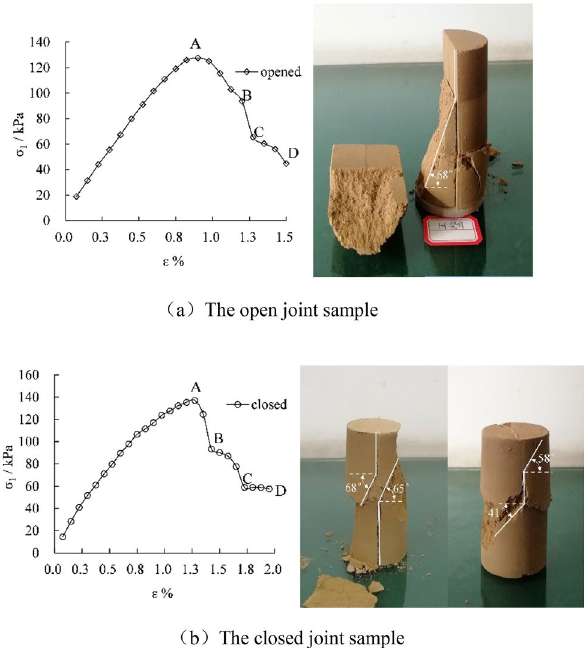
Figure 3. The stress–strain curve of vertical joint samples by unconfined compressive strength test and typical failure